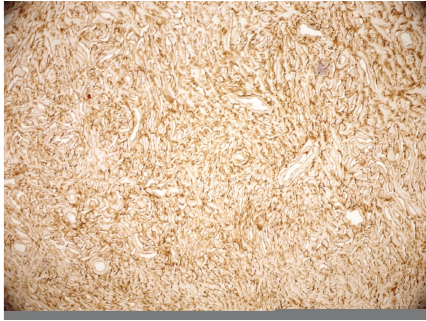
Figure 6: Diffuse CD34 staining in stroma (CD34 × 200).